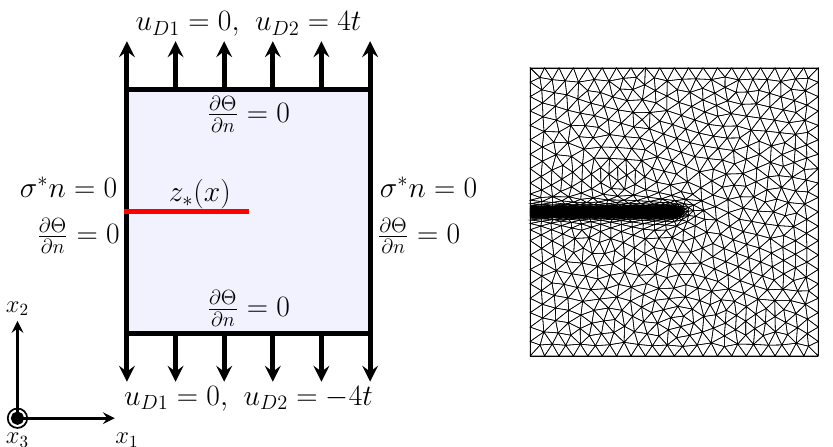
Figure 9. Domain for Section 4.3 with z ∗ ( x ) as the initial crack ( left ) and the adaptive mesh for the initial crack ( right ).